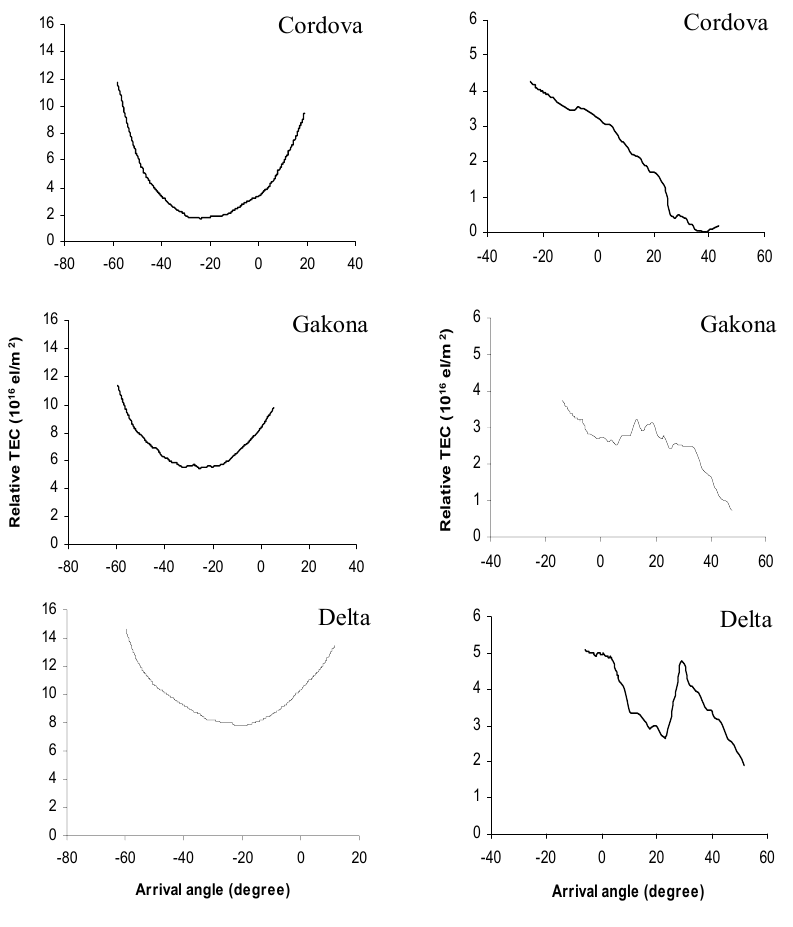
of the receivers.